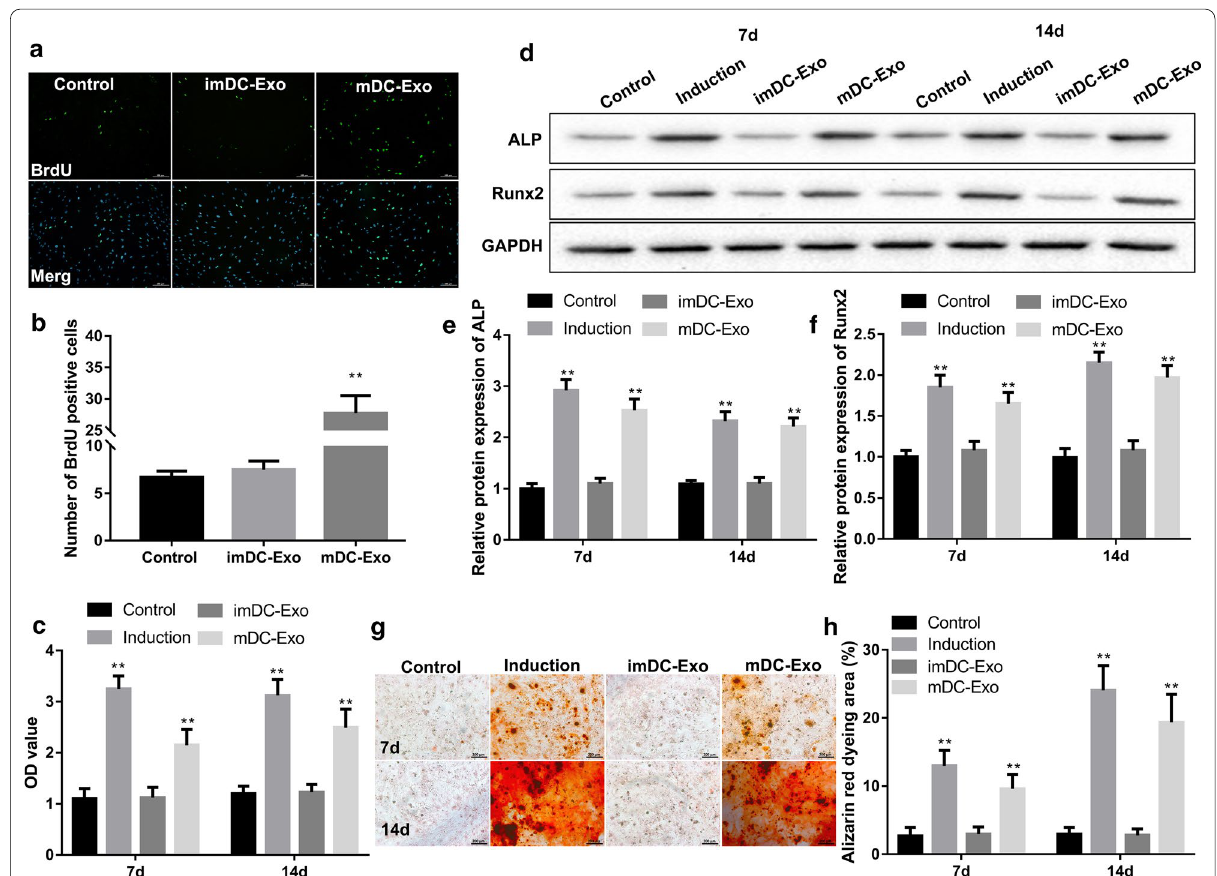
Fig. 2 mDC-Exo promoted proliferation and osteogenic differentiation of BM-MSCs. a Immunofluorocytochemical staining for BrdU (green) and DNA (DAPI, blue) in BM-MSCs and b quantitation of the number of BrdU-positive cells in BM-MSCs in the groups of control, imDC-Exo, and mDC-Exo. c ALP activities expressed in optical density (OD) values at 520 nm, d–f protein levels of ALP and Runx2 determined by western blot, g , h representative Alizarin red staining assessing calcium deposits and quantification of the percentage of Alizarin red dyeing area in BM-MSCs in the groups of control, induction, imDC-Exo, and mDC-Exo on the 7th and 14th day of culture. **P < 0.01, vs. Control